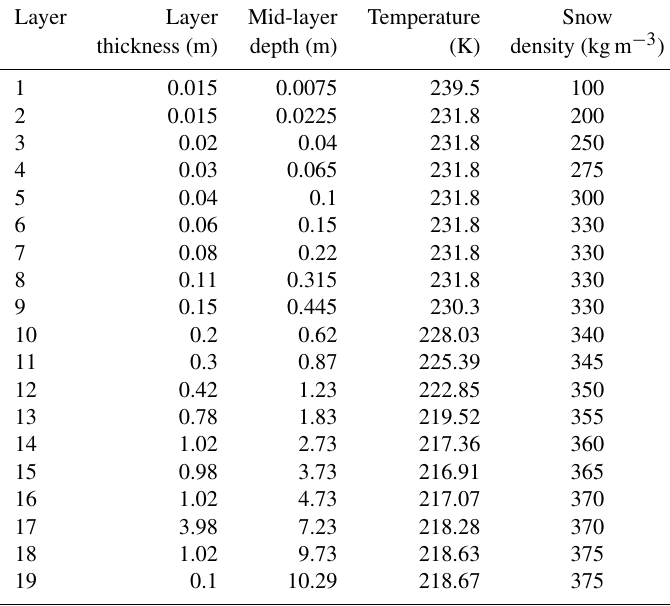
Table 1. Snowpack vertical grid and initial temperature and snow density profiles.